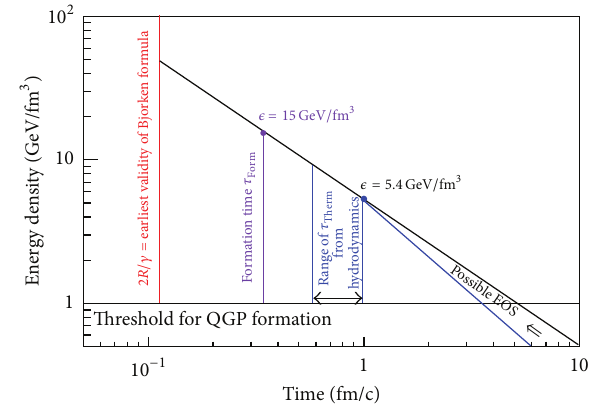
Figure 38: Schematic diagram of the time and energy density scales derived through the Bjorken picture